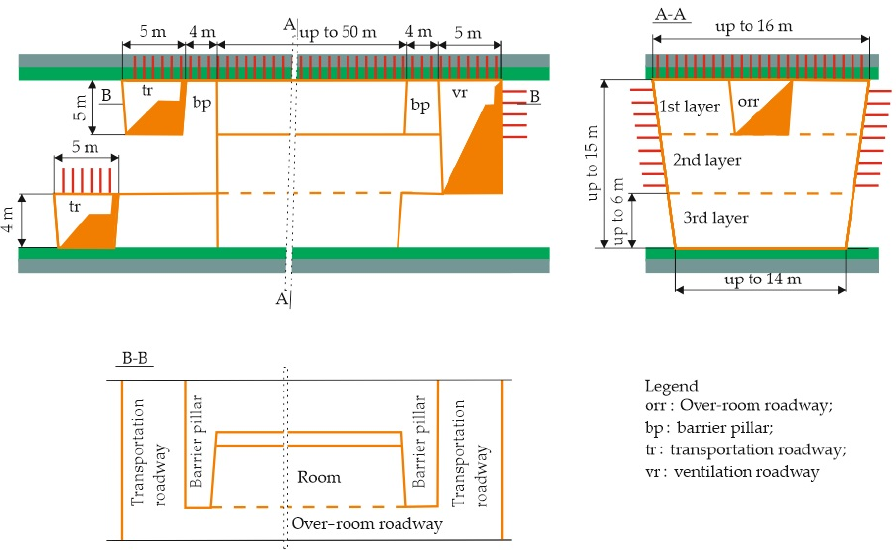
Figure 12. Room and pillar mining method in an orebody with a thickness of more than 10 m.